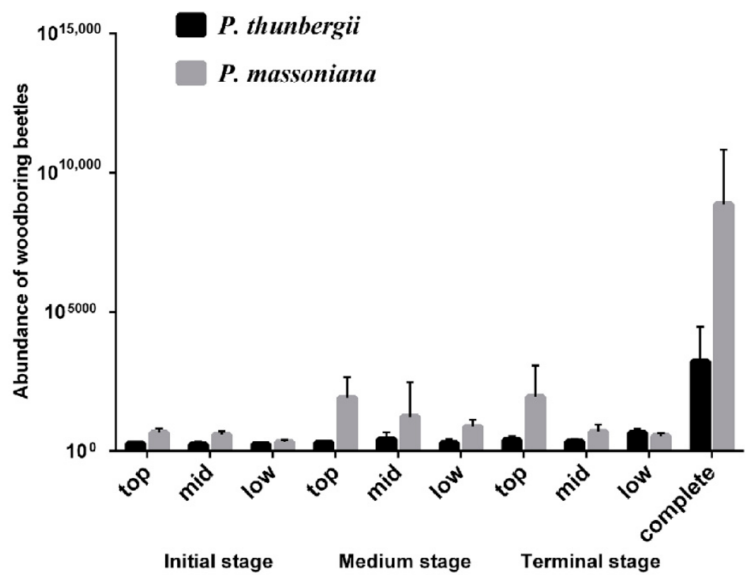
Figure A2. Abundance of xylophagous beetles in different infected stage.